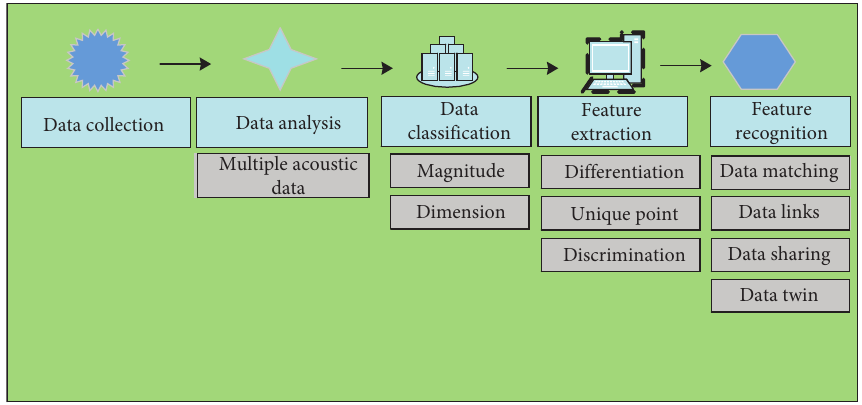
Figure 1: A logic method commonly used in data analysis.